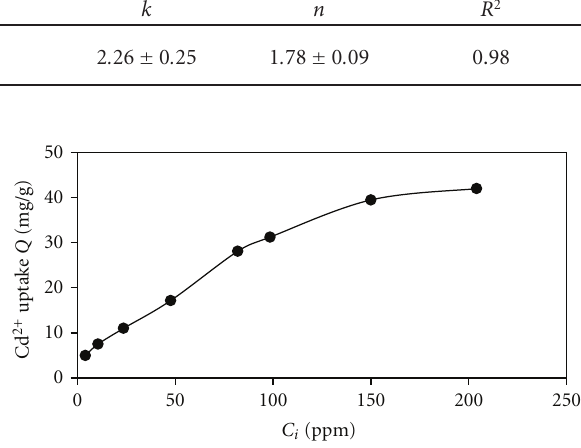
Figure 5: E ff ect of initial Cd(II) concentration on biosorption of Cd(II) at temperature 25 ◦ C; pH